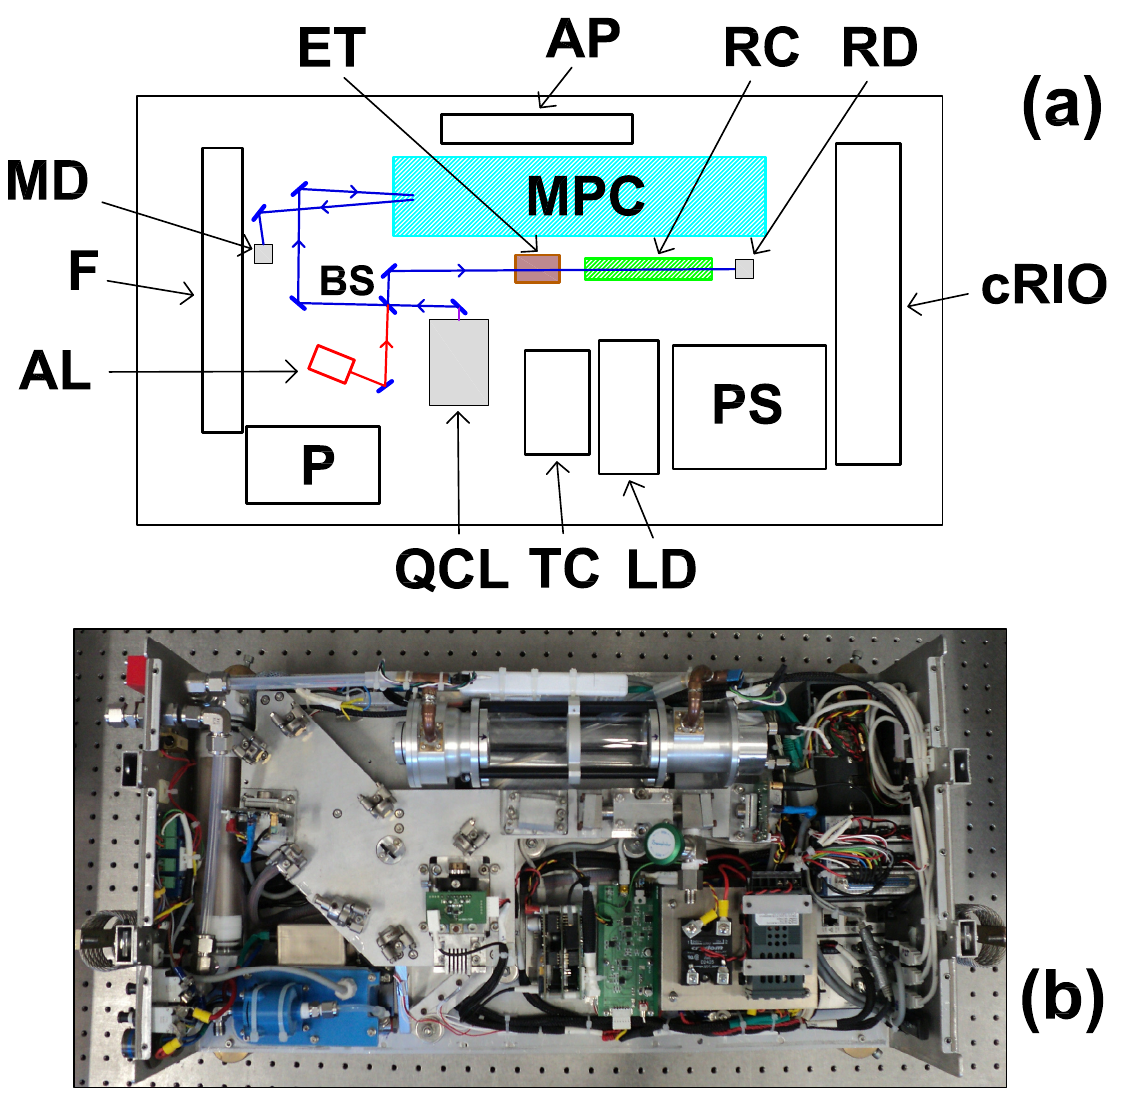
Figure 2. ( a ) Sketch and ( b ) picture of COLD2 instrument. QCL: Quantum Cascade Laser; BS: beam-splitter; ET: etalon; RC: reference cell; RD: reference detector; MPC: multipass cell; MD: main detector; AL: red laser for alignment; F: humidity filter; LD: QCL driver; TC: QCL temperature controller; cRIO: CompactRIO crate; PS: power supply; P: pump; AP: access point for wireless remote